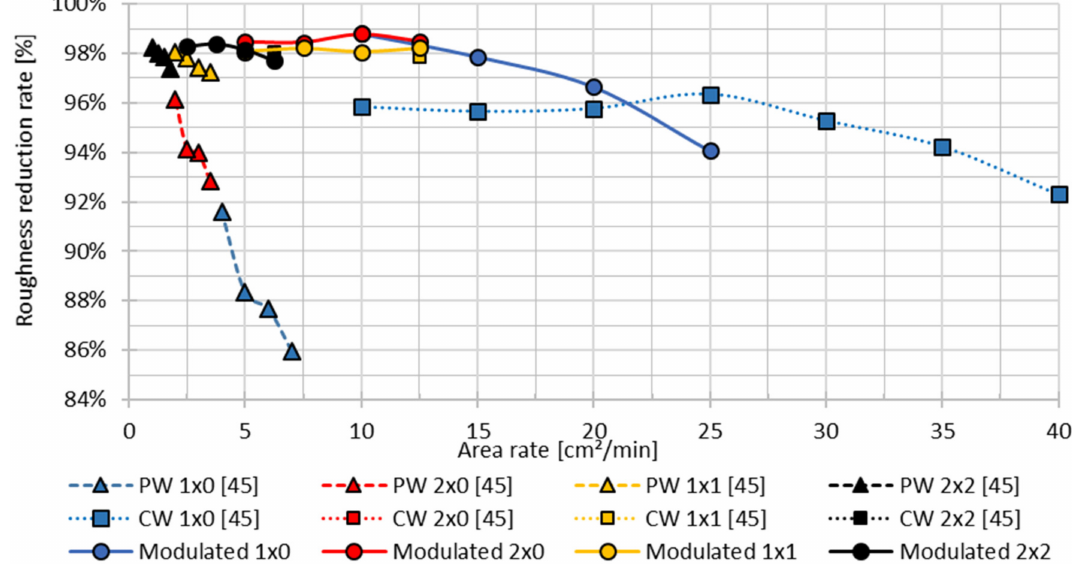
Figure 31. Achieved roughness reduction rate and polishing area rate AR with continuous laser radiation (CW) [45], pulsed laser radiation (PW) [45] and modulated laser